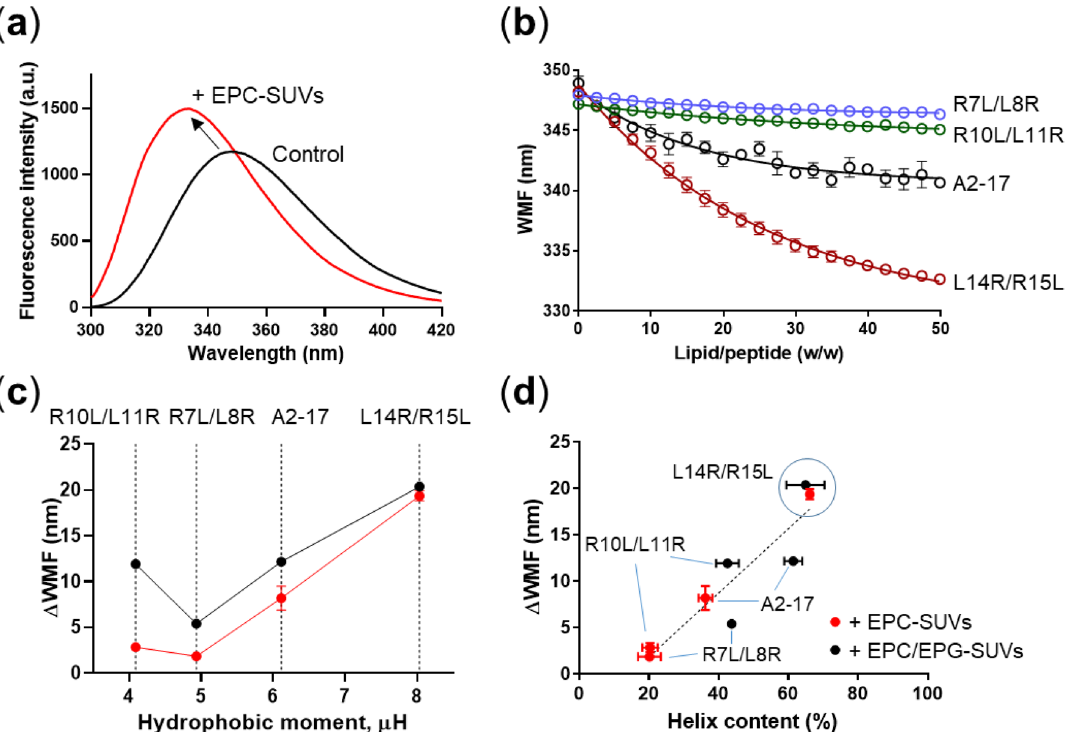
Figure 4. Trp fluorescence analysis of binding of A2-17 structural isomers to lipid membranes. ( a ) Trp fluorescence spectra of A2-17 L14R/R15L in the absence (Control) and presence of EPC-SUVs (+ EPC-SUVs). The concentrations of peptide and total lipid were 50 μg/mL and 1 mg/mL, respectively (lipid/peptide molar ratio = ~ 61). ( b ) Changes in WMF of Trp residue for peptides as a function of weight ratio of total lipid of EPC- SUVs to peptide (lipid/peptide molar ratio changes from 0 to ~ 154). One-phase decay curve fitting using the least squares method was applied to obtain the blue shift of WMF at plateau (ΔWMF). The solid lines represent the best fit. ( c ) Plot of the ΔWMF against hydrophobic moment (μH) of peptides in the presence of EPC-SUVs (red dots) or EPC/EPG-SUVs (black dots). ( d ) Correlation of ΔWMF with α-helix content of peptides bound to EPC-SUVs (red dots) or EPC/EPG-SUVs (black dots). The dotted line represents the linear regression of the data (coefficient of determination r 2 = 0.84). Data are expressed as mean ± isomers (Fig. 5c). These results indicate that A2-17 L14R/R15L causes larger-sized, stable membrane pores and mediates the permeation of a greater number of ions, ionic molecules, or both, compared with the other isomers. Atomic force microscopic (AFM) analysis for peptide‑induced membrane perturbation. We further performed AFM analysis to investigate peptide-induced membrane perturbation as a result of peptide binding to lipid membranes. Figure 6a presents AFM images of EPC/EPG/cholesterol-large unilamellar vesi- cles (LUVs) and distearoylphosphatidylcholine (DSPC)/distearoylphosphatidylglycerol (DSPG)-LUVs in the absence and presence of A2-17. An addition of peptide caused collapse of EPC/EPG/cholesterol-LUVs into membrane patches with a height of ~ 5 nm, which corresponds to the thickness of lipid bilayers 32 . A lipid vesicle on a solid substrate has been shown to expand its spherical morphology to a lipid bilayer patch when vesicle stiffness cannot endure the traction stress derived from the adhesion energy of the vesicle with the substrate 32,33 . Therefore, deformation of EPC/EPG/cholesterol-LUVs by the addition of A2-17 indicates a decrease in the stiffness of lipid vesicles. On the other hand, DSPC/DSPG-LUVs in the presence of peptides maintained their spherical morphology. Using DSPC/DSPG-LUVs, we obtained force–deformation curves (Fig. 6b), in which the slope of the force–deformation curve represents the stiffness of a lipid vesicle: the more densely the lipids pack in the mem- brane, the larger the stiffness value 34 . Therefore, the decrease in slope by the addition of A2-17 indicates the peptide-induced destabilization of lipid packing in the membrane. We defined this peptide-induced membrane perturbation as the decrease in the lipid vesicle stiffness using ( S control − S )/ S control , where S control and S are the stiffnesses of control lipid vesicles and lipid vesicles with peptide, respectively. The plot of membrane perturba- tion values for the A2-17 isomers against the hydrophobic moment (Fig. 6c) distinctly demonstrated that the membrane perturbation level increases with the peptide hydrophobic moment.